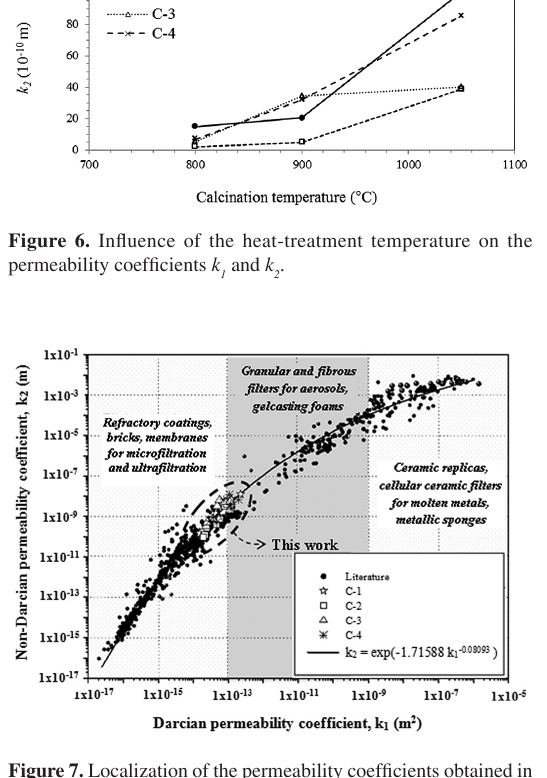
Figure 7. Localization of the permeability coefficients obtained in this work in comparison with those of other structures 21 .